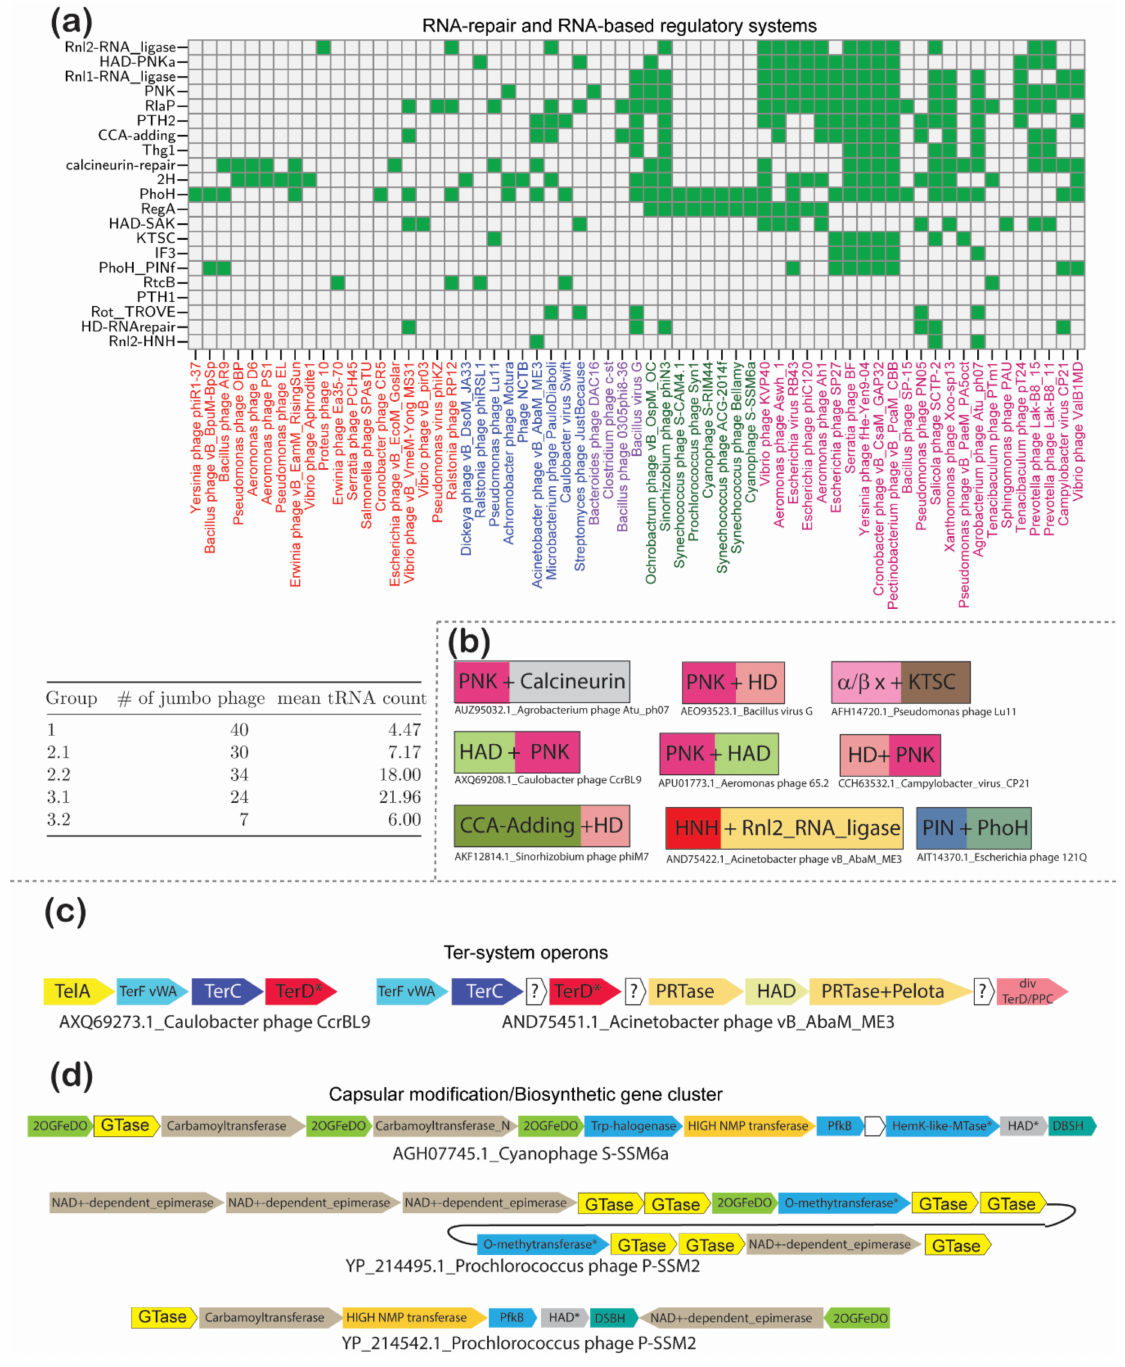
Figure 7. RNA-repair and RNA-based regulatory systems. ( a ) Phyletic vector diagrams and ( b ) domain architectures of jumbo proteins predicted to be involved in RNA-repair and RNA-based conflict and regulation. Also shown in ( a ) is the mean tRNA count for the different groups of jumbo phages. Also illustrated are the gene neighborhoods of ( c ) Ter-system and ( d ) capsular polysaccharide modification systems. GTase: glycosyltransferase. Genes are represented as boxed arrows with arrow-heads pointing to the 3 (cid:48) ends of the gene. Neighborhoods and architectures are denoted by their accession numbers and phage names separated by underscores. The accession number in the label corresponds to the gene marked with a *. In domain architectures, distinct domains are colored